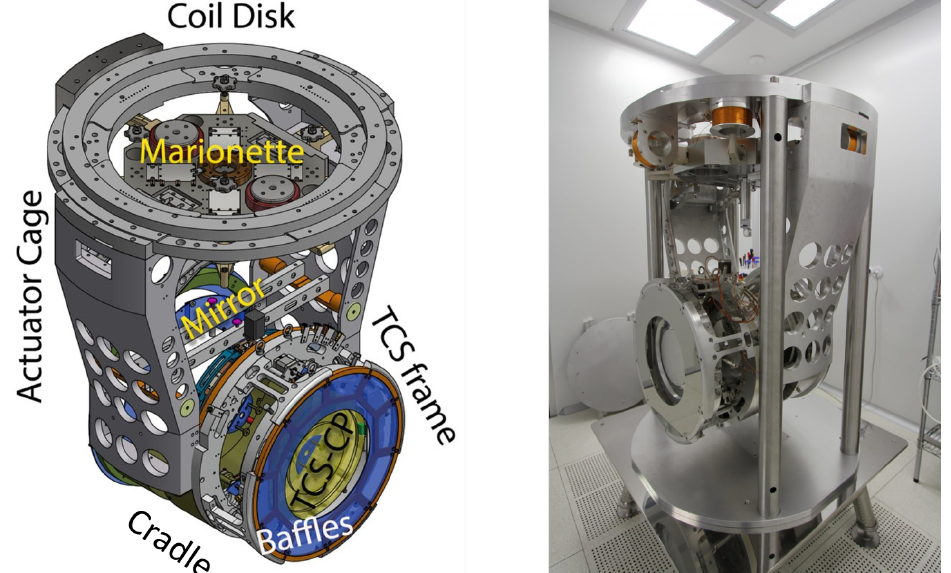
Figure 5. A scheme (on the left ), and the assembly in clean room (on the right ) of the Advanced Virgo payload [99]. Besides the suspension elements—mirror, marionette and actuator cage—the components belonging to the thermal compensation system are present. Baffles for stray light mitigation systems are also visible. Credit: The Virgo